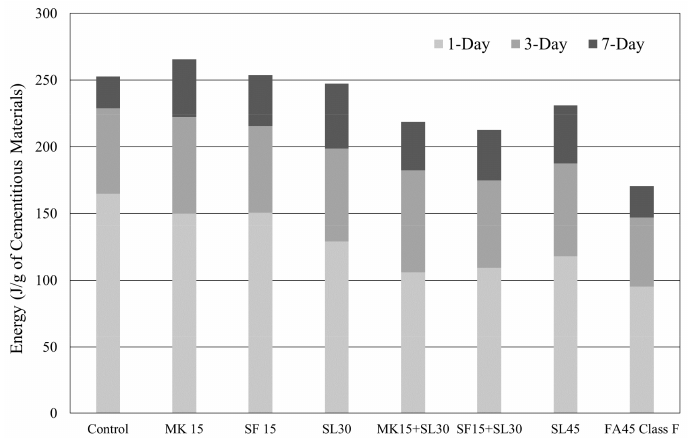
Figure 5. Heat of hydration of the 422 group mixtures.